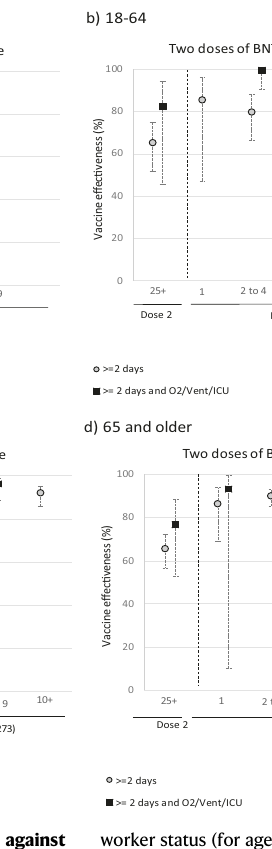
worker status (for age <65), clinical risk group status (for age <65), clinically extremelyvulnerable,severelyimmunosuppressed,andpreviouslytestedpositive. a 18 – 64: two doses of ChAdOx1-S with a BNT162b2 or mRNA-1273 third dose, b 18 – 64: two doses of BNT162b2 with a BNT162b2 or mRNA-1273 third dose, c 65 andolder:twodosesofChAdOx1-SwithaBNT162b2ormRNA-1273thirddose, d 65 and older: two doses of BNT162b2 with a BNT162b2 or mRNA-1273 third